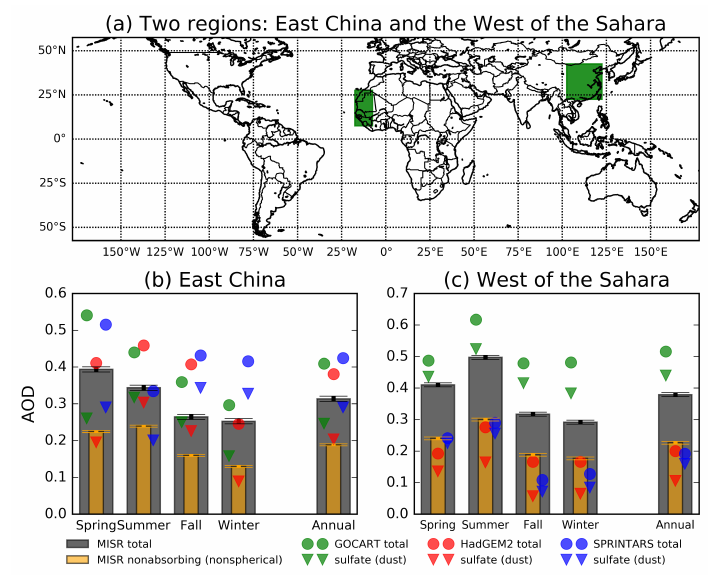
Figure 6. ( a ) Maps of the two regions, East China and west of the Sahara Desert. ( b ) Seasonal cycles and averages of total AOD (black bars) and non-absorbing AOD (orange bars) from MISR over East China. The error bars represent uncertainties due to the 5-year subsampling. The dots and triangles represent the corresponding total and nonabsorbing AOD from the three AEROCOM models. ( c ) Same as ( b ) but for total and non-spherical AOD in west of the Sahara